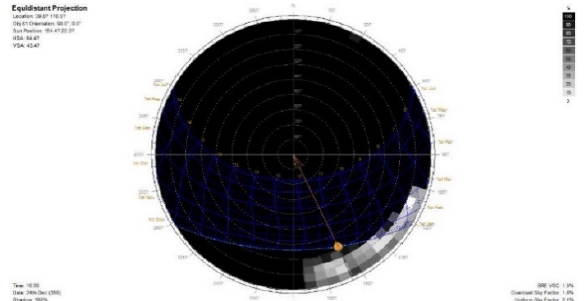
Figure 11: Annual solar shading percentage sun-path diagram at west painting